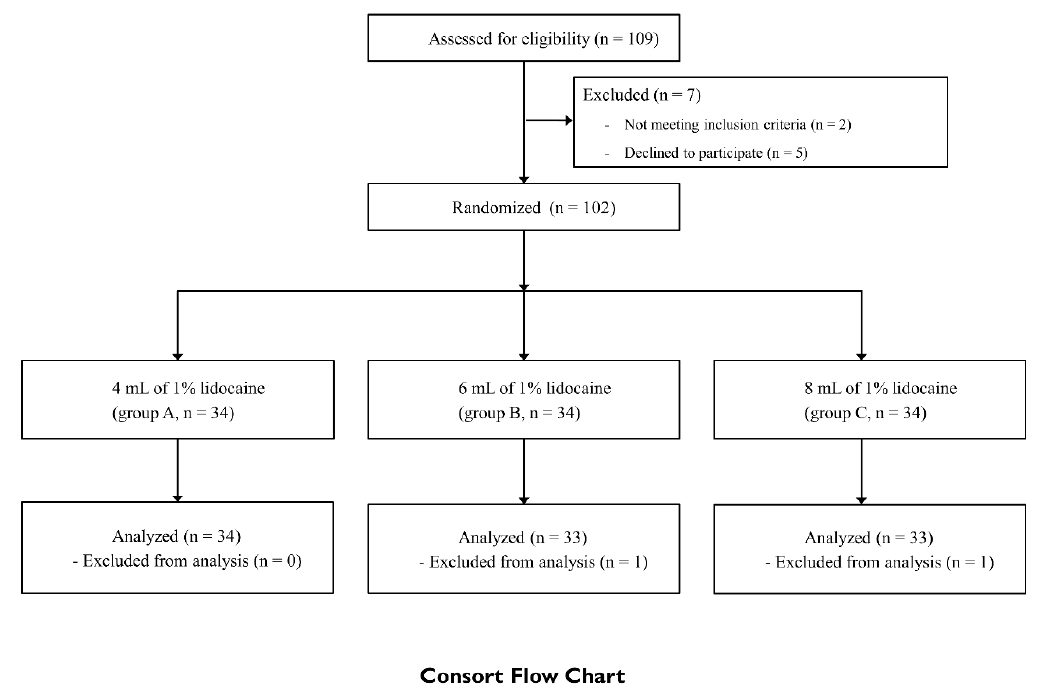
Figure 2. Consolidated Standards of Reporting Trials (CONSORT) flow diagram. Table 1. Baseline Demographic and Clinical Characteristics of Study